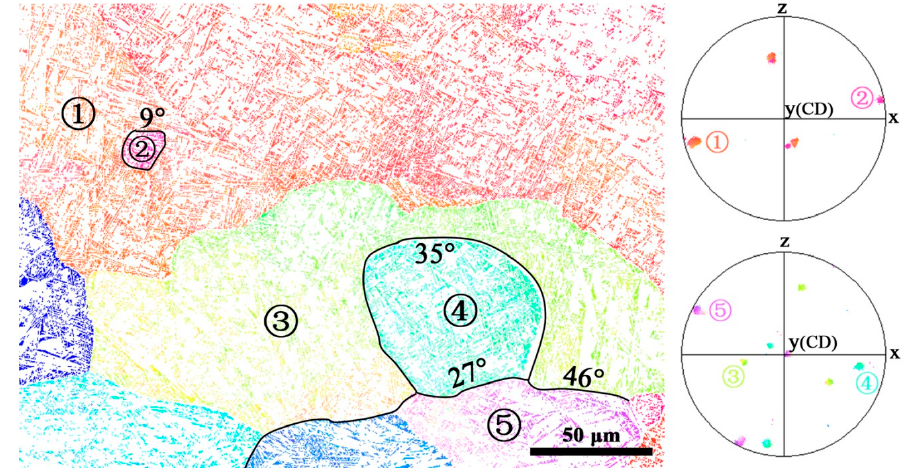
Figure 4. Local inverse pole figure map for the β phase after deformation at 0.02 s − 1 , by using a step size of 0.3 μ m. Some grain boundaries are outlined by solid lines to show the DRXed grains, and the corresponding grain boundary misorientations are also indicated. For the micrograph, the compression direction is vertical. {100} pole figures are presented to show the crystallographic relationship of neighboring grains, where y denotes the compression direction, x and z are the radial direction of the deformed samples.